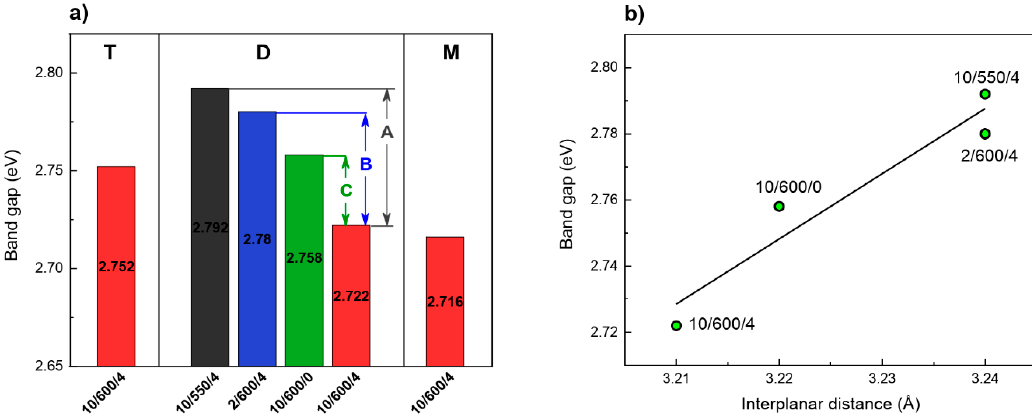
Figure 11. Optical energy band gap for carbon nitrides synthesized from various precursors and under various condensation conditions ( a ), (label A describes the condensation temperature effect, label B—the heating rate; and C—time of annealing effect) and band gap/interlayer distance relationship ( b ).